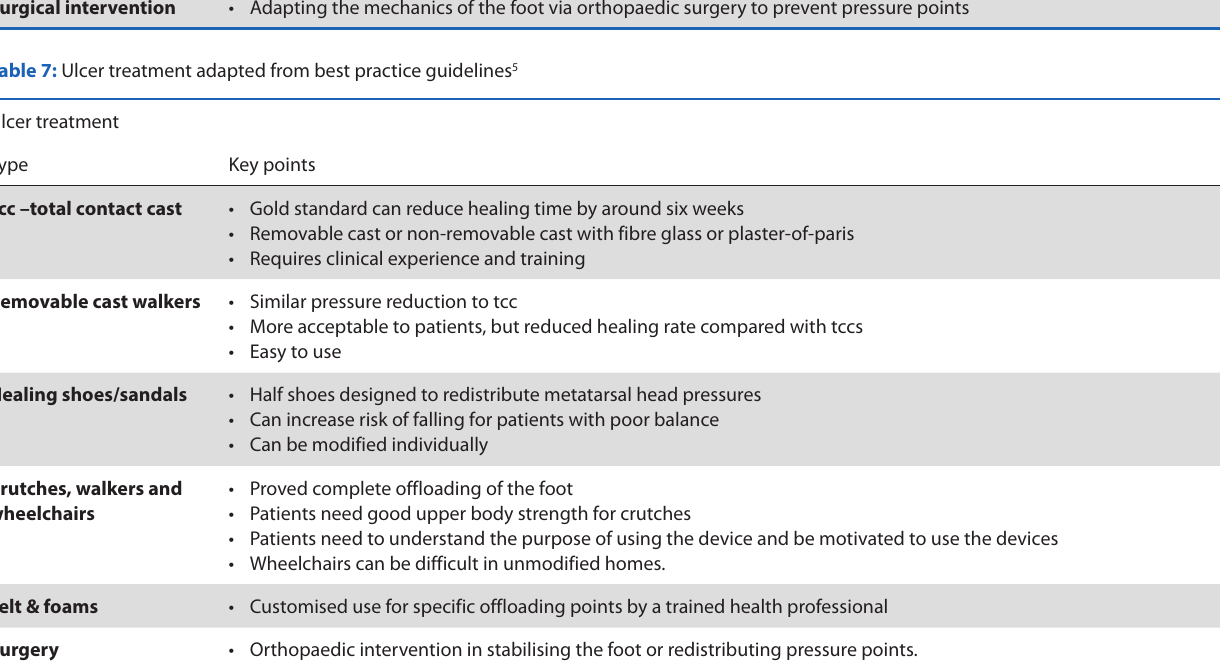
Table 7: Ulcer treatment adapted from best practice guidelines 5